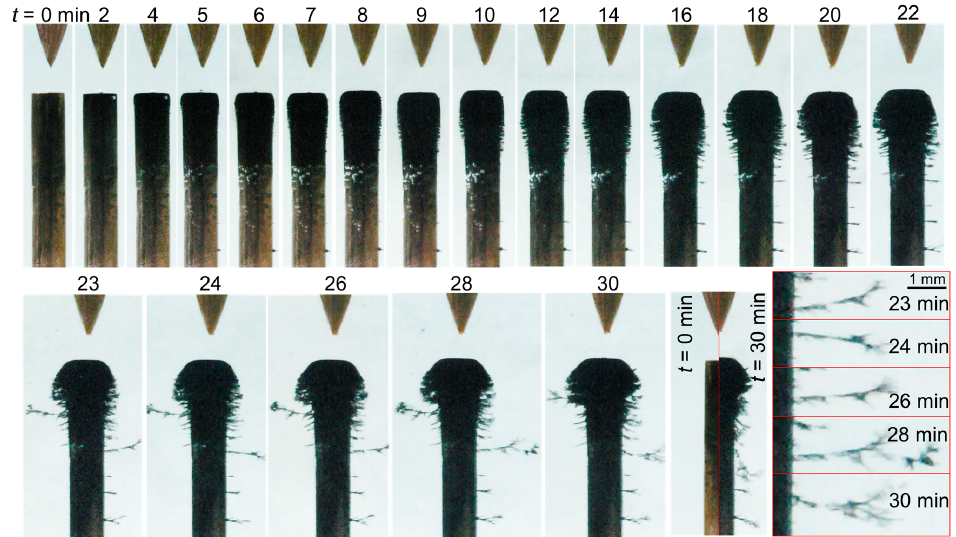
Figure 6. Temporal evolution of the liquid-electrode zone for case 4 ( σ 0 = 64 µS/cm). Nanomaterials 2020 , 10 , x FOR PEER REVIEW It is worth noting that once the high voltage was switched off, significant amounts of the materials, previously collected at the cathode, were ejected and slowly diffused within the solution towards the bottom of the chamber. Such ejection implies that the synthesized materials were electrostatically bound to the cathode (Figure 7).